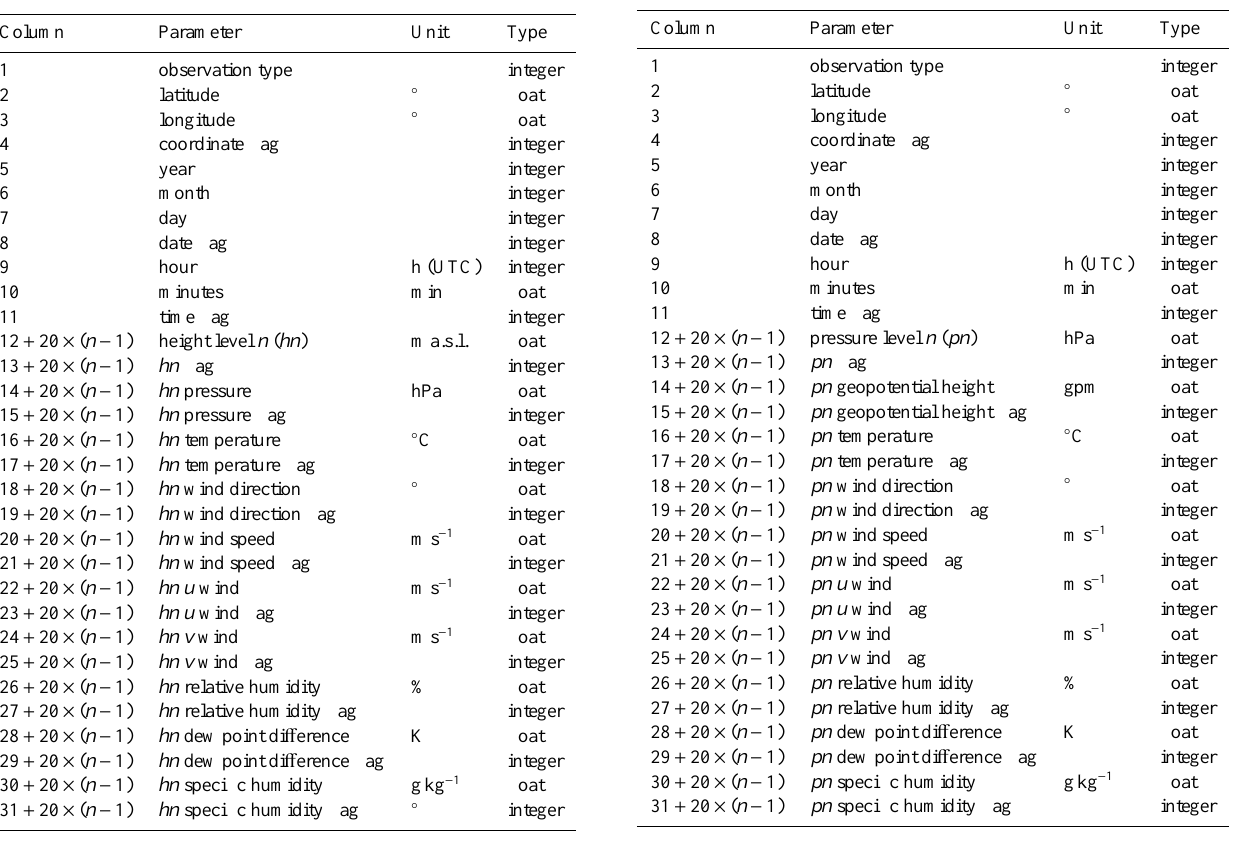
Table 6. Definition of the columns in the moving upper-air pressure added to flag values signify observation values obtained during as- cent / descent of a kite or tethered balloon (see Table 7). n runs from 0 to